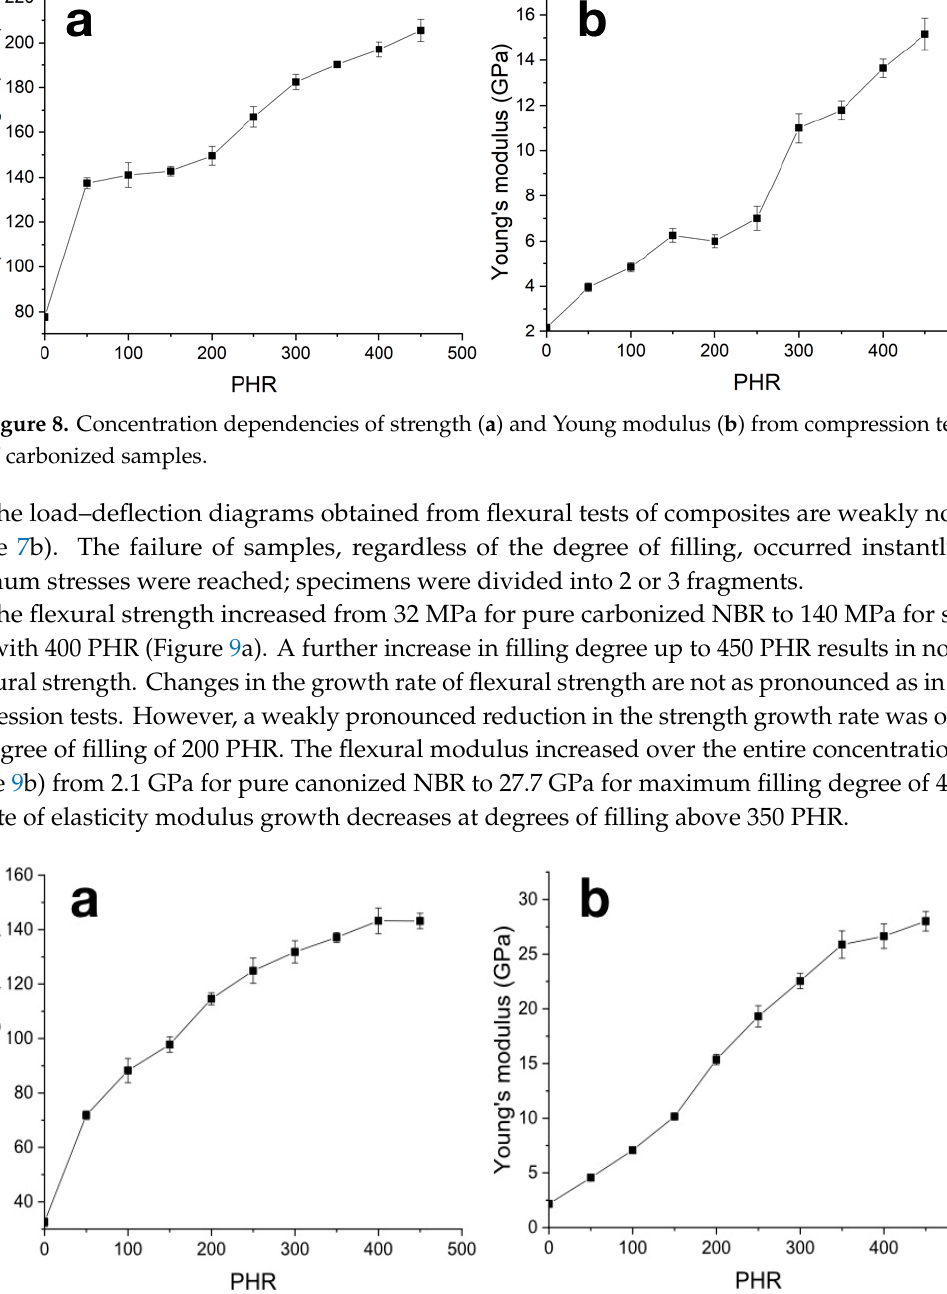
Figure 10. Dependencies of thermal diffusivity ( a , b ) and thermal conductivity coefficient ( c , d ) on the filling degree ( a , c ) and temperature ( b , d ) for carbonized composites.